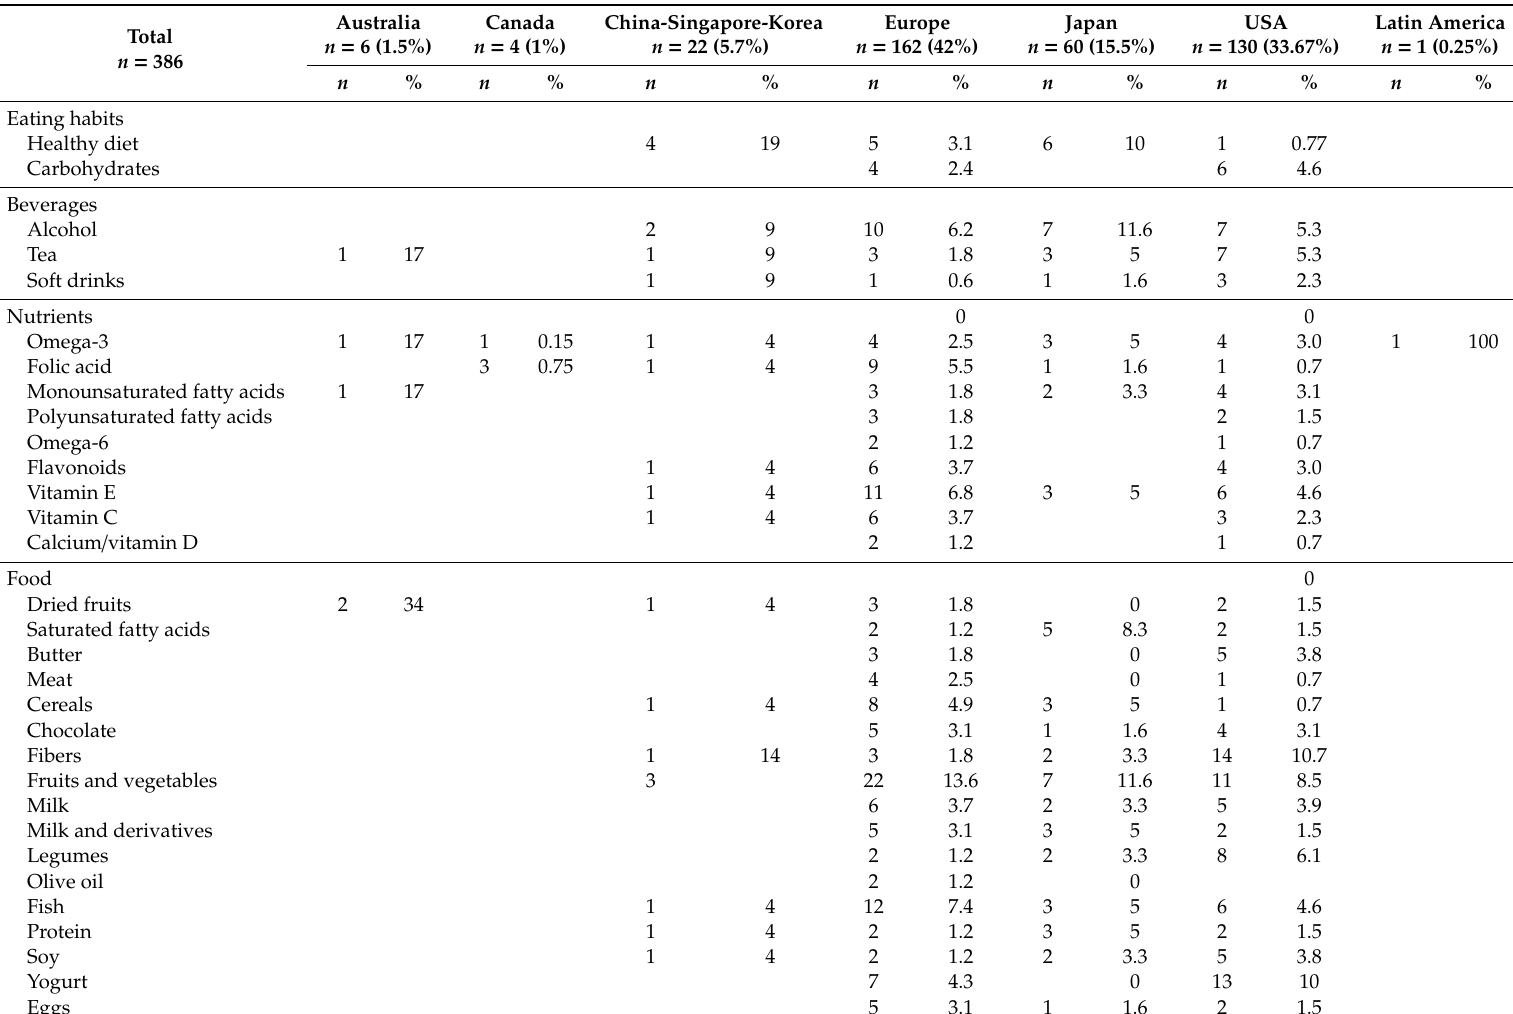
Table 2. Distribution of primary studies included in meta-analyses considered according to geographic area and type of nutritional